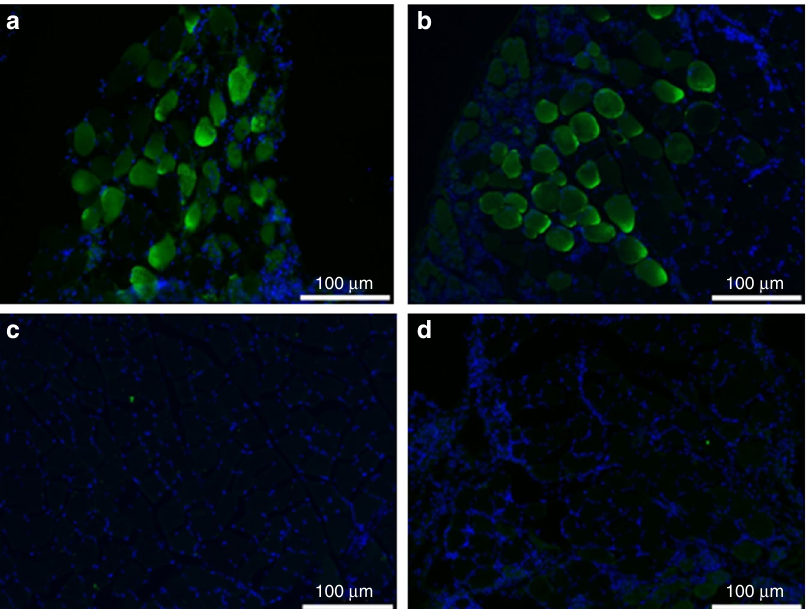
Fig. 2 Expression of DMAb- α PcrV and DMAb-BiSPA in mouse skeletal muscle. BALB/c mice received a DNA injection, in the TA muscle with DMAb- α PcrV or DMAb-BiSpA DNA followed by in vivo EP. a DMAb- α PcrV, b DMAb-BiSPA, c pGX0001 empty vector backbone, and d naïve muscle. Muscle tissue was harvested 3 days post DMAb injection and probed with a goat anti-humanIgG Fc antibody, followed by detection with anti-goat IgG AF88 and